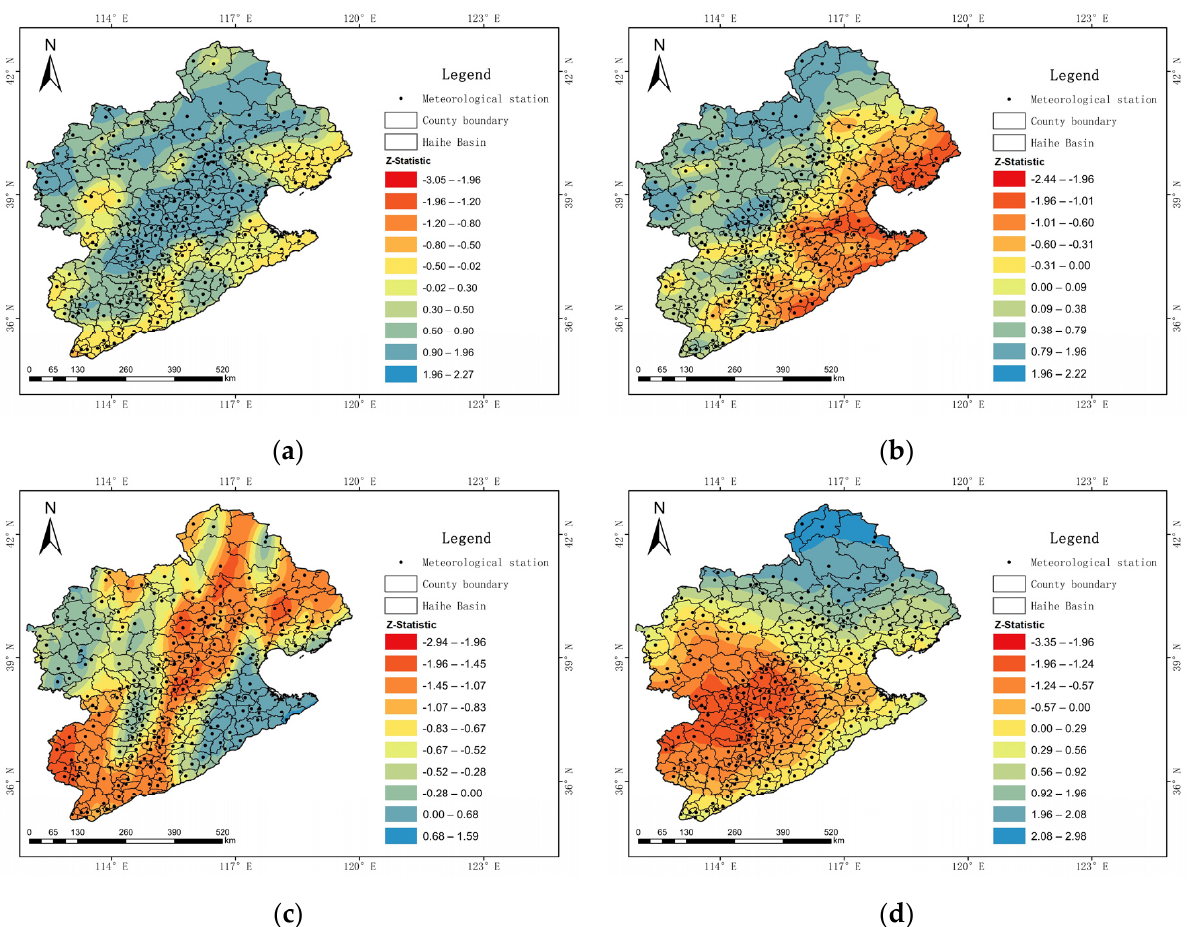
Figure 6. Spatial distribution of precipitation significance for different seasons. ( a ) Spring; ( b ) summer; ( c ) autumn; ( d )